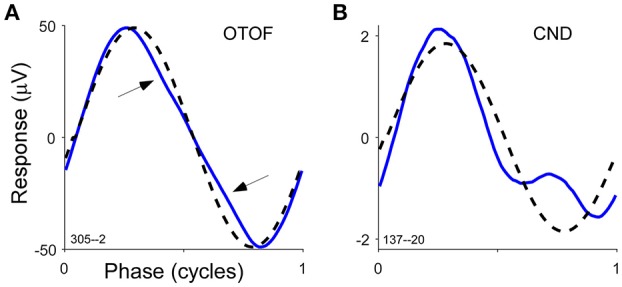
Average 500 Hz cycle for two different known etiologies of the ANSD group. (A) Subject had confirmed otoferlin gene mutation. To 500 Hz distortions (arrows) due to the ANN can be identified. (B) Subject had cochlear nerve deficiency as identified by neuroimaging but has strong ANN distortions in the 500 Hz average cycle. These examples illustrate the sensitivity of ECochG for detecting neural activity when little is expected to be present.